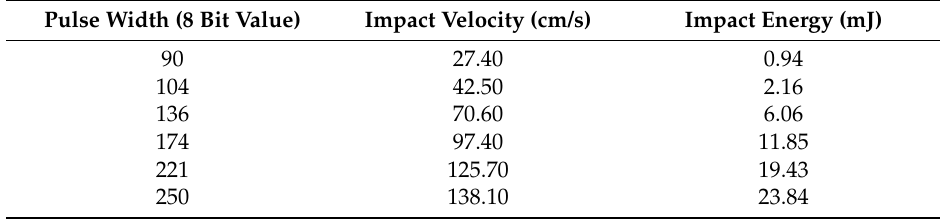
Table 4. Relative standard deviation (RSD) of impact velocity or pressing force calculated for each microneedle array (MNA) application at 125–138 cm/s and 17–25 N.